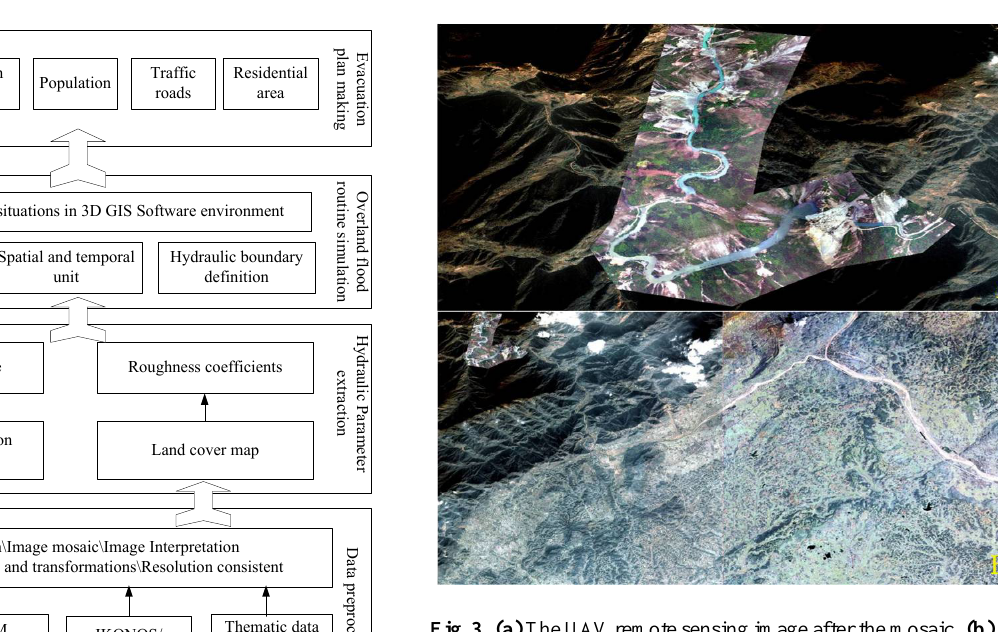
Fig. 3. (a) The UAV remote sensing image after the mosaic. (b) The IKONOS